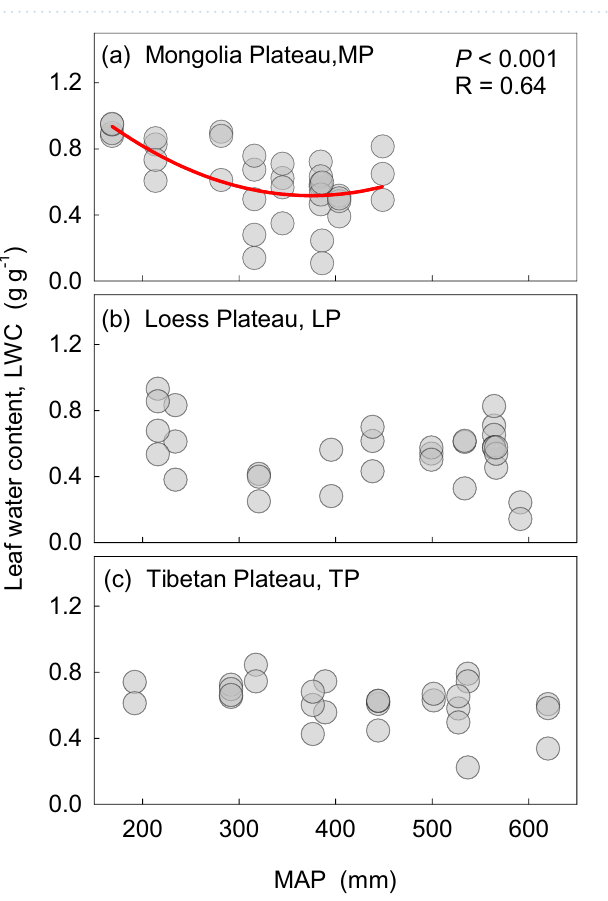
Figure 3. Results of redundancy analysis between leaf water content (LWC) and influencing factors. Numbers in circles represent the interpretation rate of the factor for LWC. MAT, mean annual temperature; MAP, mean annual precipitation; C/N, C/N ratio of soil.